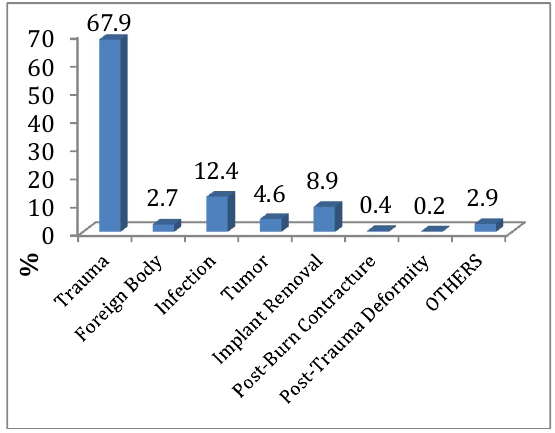
Figure2. Case distribution in percentage